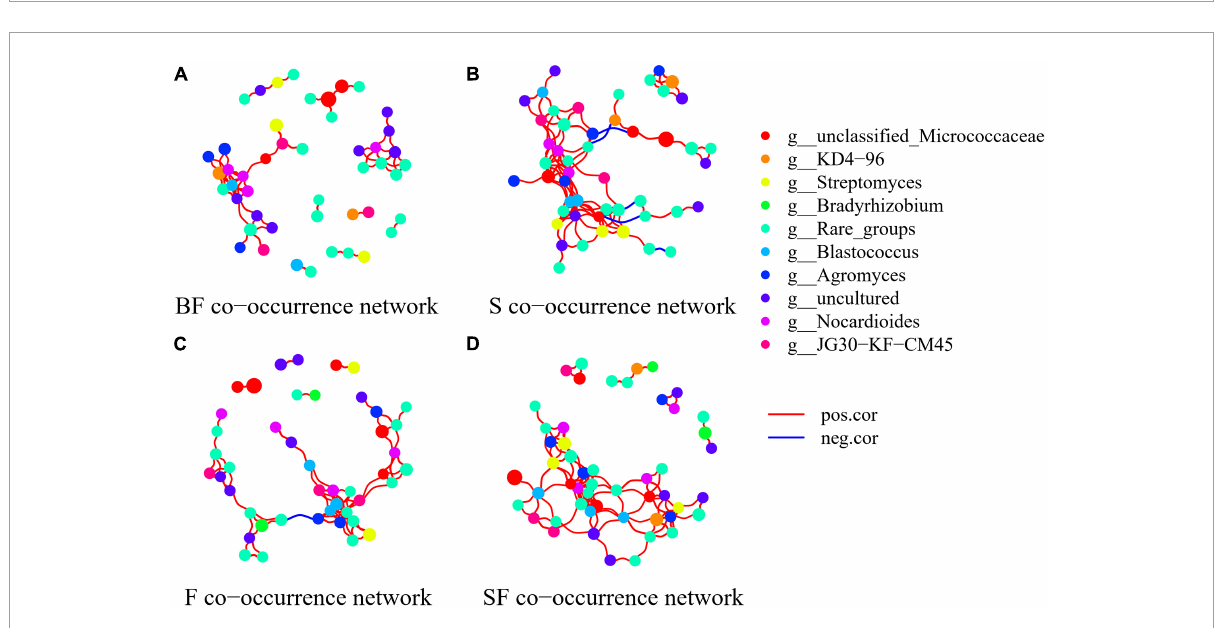
FIGURE7 Network analysis showed the co-occurrence patterns of soil bacterial taxa at seedling stage in different treatments. (A) BF, (B) S, (C) F, and (D) SF. The size of each node is proportional to the relative abundance. The blue line represents a significant negative relationship ( p < 0.05) between nodes, and the red line represents a significant positive relationship ( p < 0.05) between